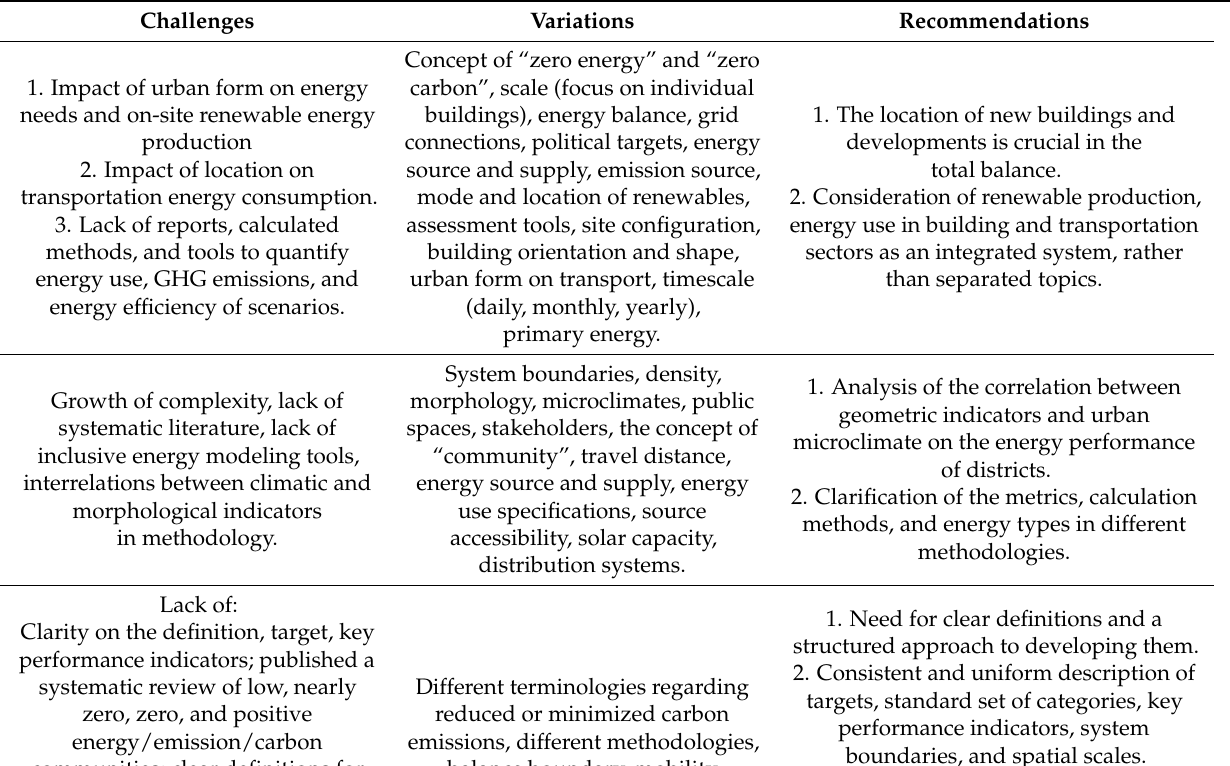
Table 3. Review of NZC variation by selected